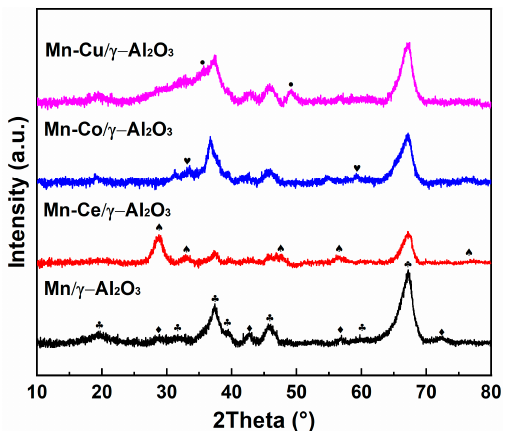
Figure 1. XRD patterns of the Mn-X/ γ -Al 2 O 3 catalysts: ♣ γ -Al 2 O 3 , ♦ MnO 2 , ♥ Co 3 O 4 , ♠ CeO 2 and ● CuO.